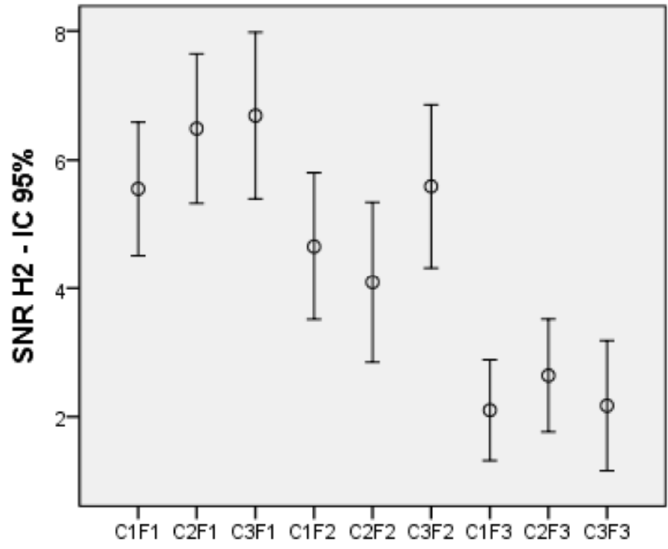
Figure 6. SNR means of the 9 conditions for the 2nd harmonic with 95% confidence intervals.